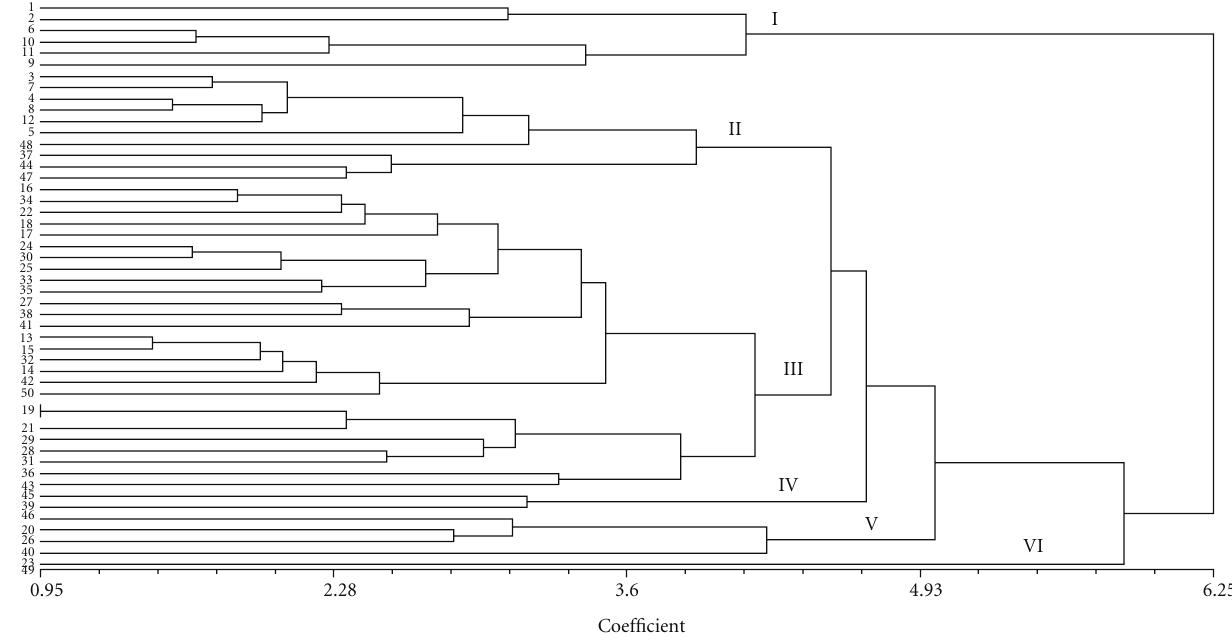
Figure 1: The dendrogram of 50 accessions of upland rice based on 12 quantitative